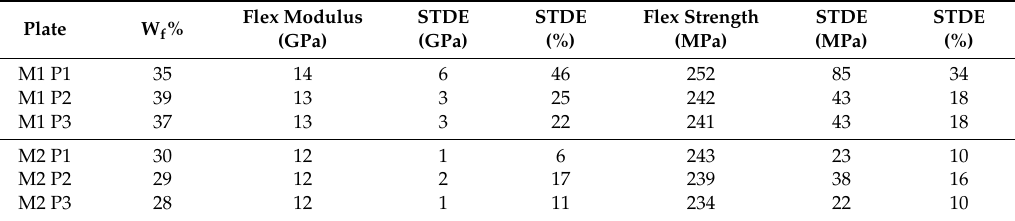
Table 4. Experimental flexural results for the CF/Epoxy plates produced with WL-CF mats from Method 1 and Method 2 of nonwoven production .